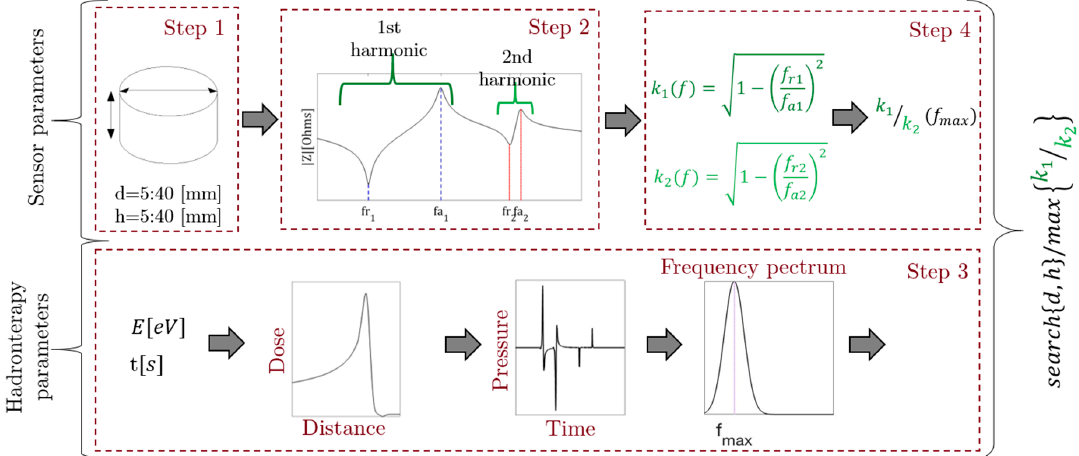
Figure 3. Optimization process diagram with input parameters for the thermoacoustic and piezoelectric parts. Time and energy for the first model and diameter and thickness for second one.